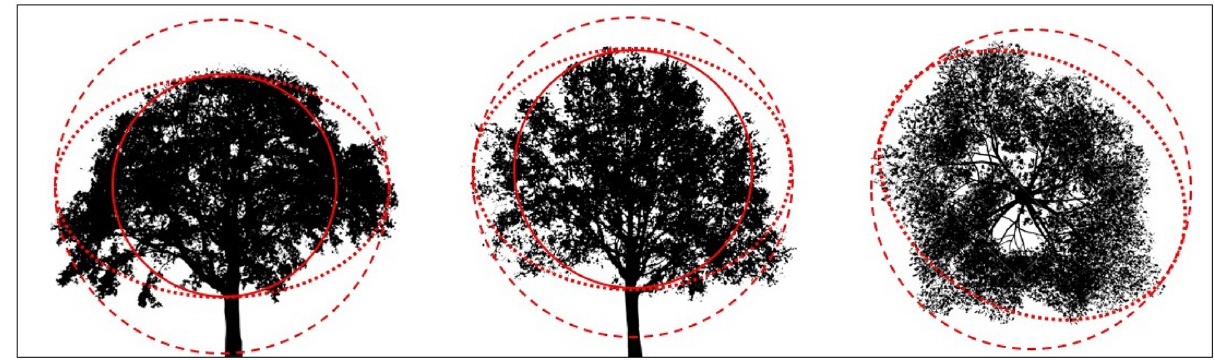
Figure 2. Illustration of various crown envelope definitions applied to three different trees (two side view, one top view). The solid line is a sphere based on the vertical extent of the crown, the dashed line is a sphere based on the horizontal extent of the crown, and the dotted line is an ellipsoid based on the horizontal and vertical extent of the